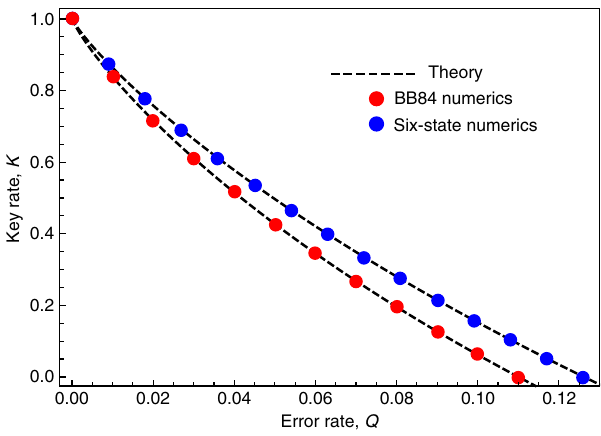
Figure 1 | Key rate for two well-known QKD protocols. Here we compare our numerics (from Theorem 1) with the theoretical curves. The results of our numerical optimization for the BB84 and six-state protocols are respectively shown as red and blue dots. The known theoretical curves for these protocols are also shown as black dashed lines. The dots should be viewed as reliable lower bounds on the key rate, but in this case they happen to be perfectly tight, coinciding with the theoretical